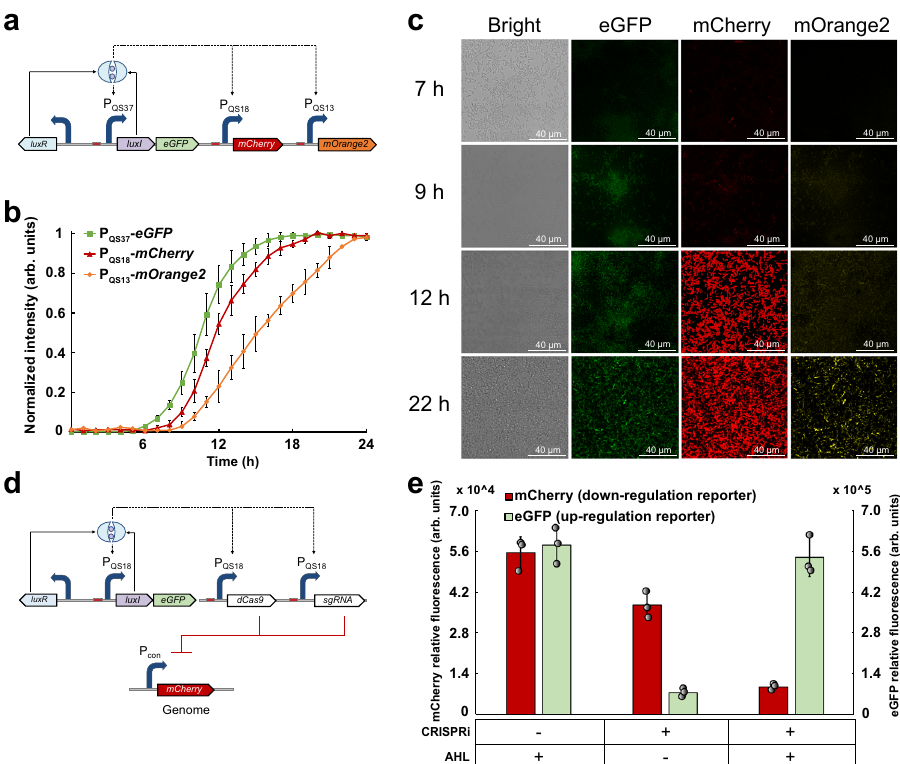
Fig. 3 Autonomous and simultaneous control of three different gene targets by QS variants. a Architecture of the QS circuit that simultaneously regulates the expression of eGFP , mCherry , and mOrange 2, under control of the P QS37 , P QS18 , and P QS13 , respectively. b Fluorescence pro fi les for eGFP , mCherry , and mOrange 2 in the strain containing the designed QS circuit. For all three fl uorescent proteins, the fl uorescent intensity of each time point was normalized by their corresponding peak fl uorescence value. c Laser scanning confocal images captured in a single cell containing the designed QS circuit. Images were taken at 7, 9, 12, and 22 h and under three different excitation wavelengths. Bar = 40 μ m. The data were generated from three independent experiments. d Architecture of the QS circuit for simultaneous up- and downregulation of two different gene targets. e Peak fl uorescent intensities of mCherry and eGFP when introducing CRISPRi into this system. Data shown are mean ± SD ( n = 3 independent experiments). Source data are provided as a Source Data fi